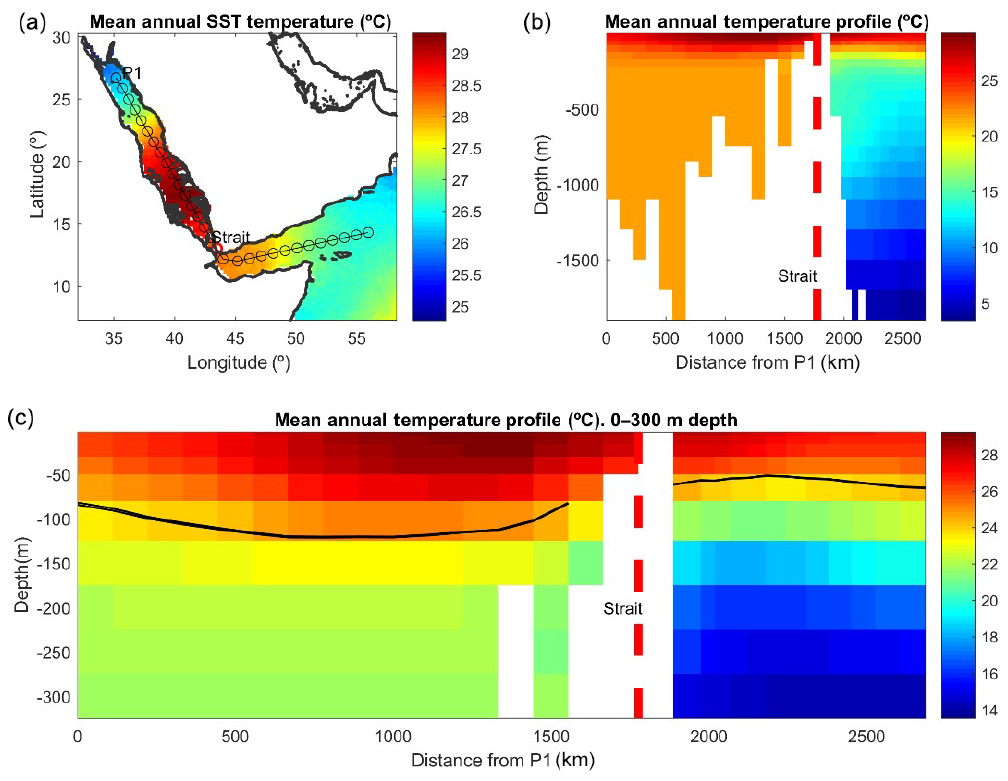
Figure 11. Average temperature from TEMPERSEA computed for the period 1958–2017. (a) Averaged SST; dots indicate the location of the vertical section shown in the following figures. (b) Vertical section; (c) zoomed-in view of the vertical section for the upper 300m. The black line indicates the isotherm of 23.5 ◦